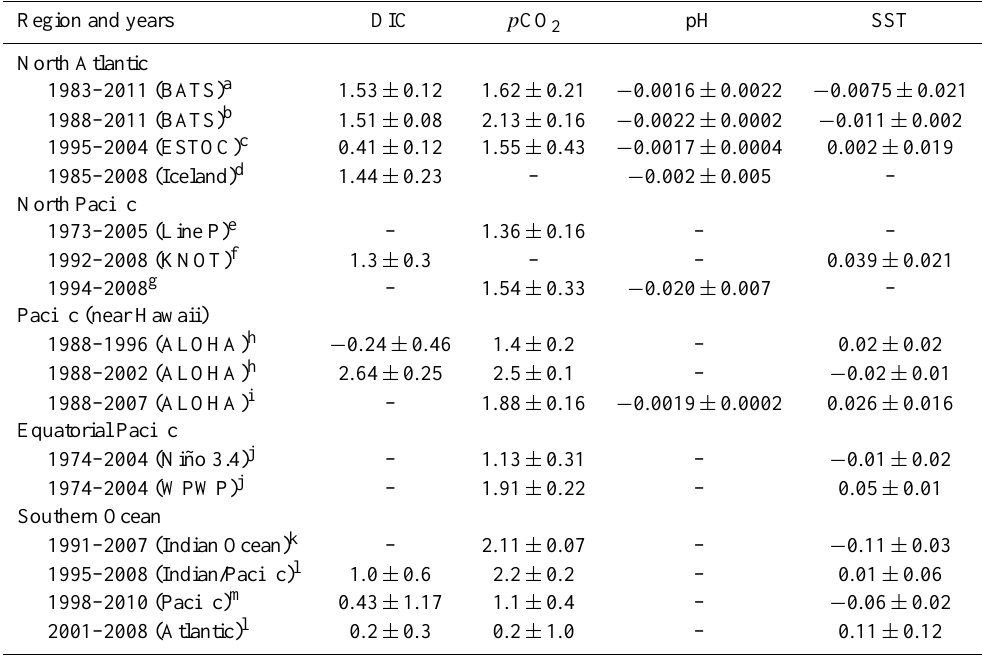
Table 1. Observed trends/year of dissolved inorganic carbon (DIC; mmol m − 3 ), p CO 2 (ppmv or µatm), total pH and sea-surface temperature (SST; ◦ C), all variables on surface level. Note that we include only directly measured DIC, that is, not salinity-normalized. Region and years